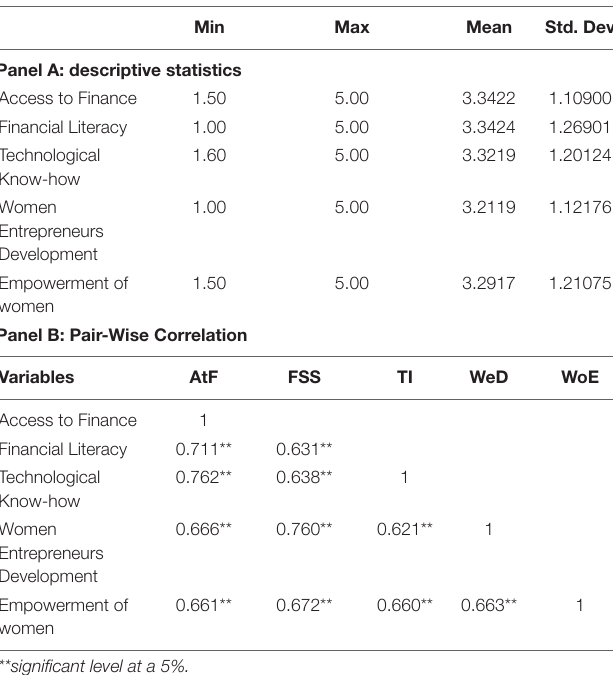
TABLE 5 | Descriptive statistics of constructs.